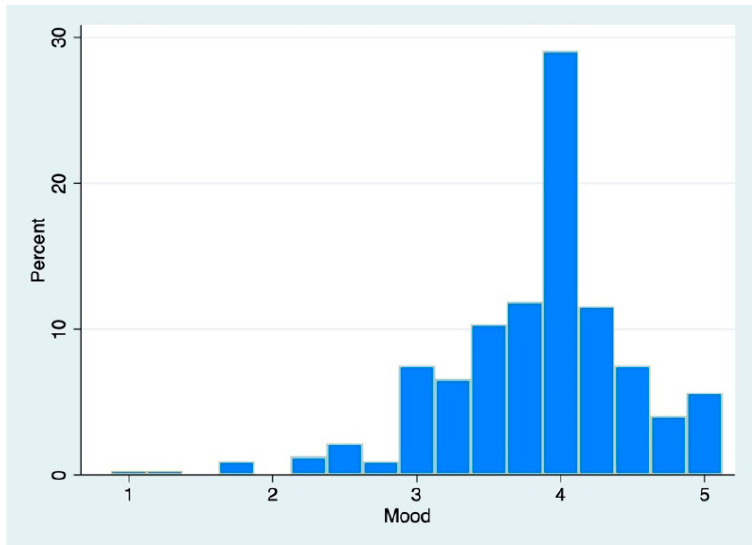
Figure 1. The distribution of participants’ moods.